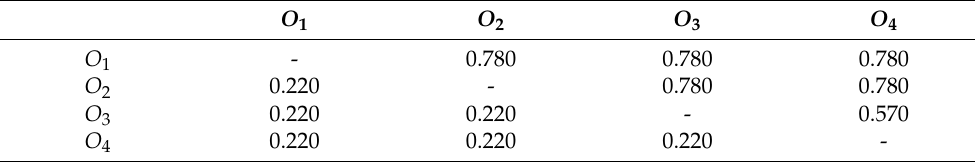
Table 4. The concordance